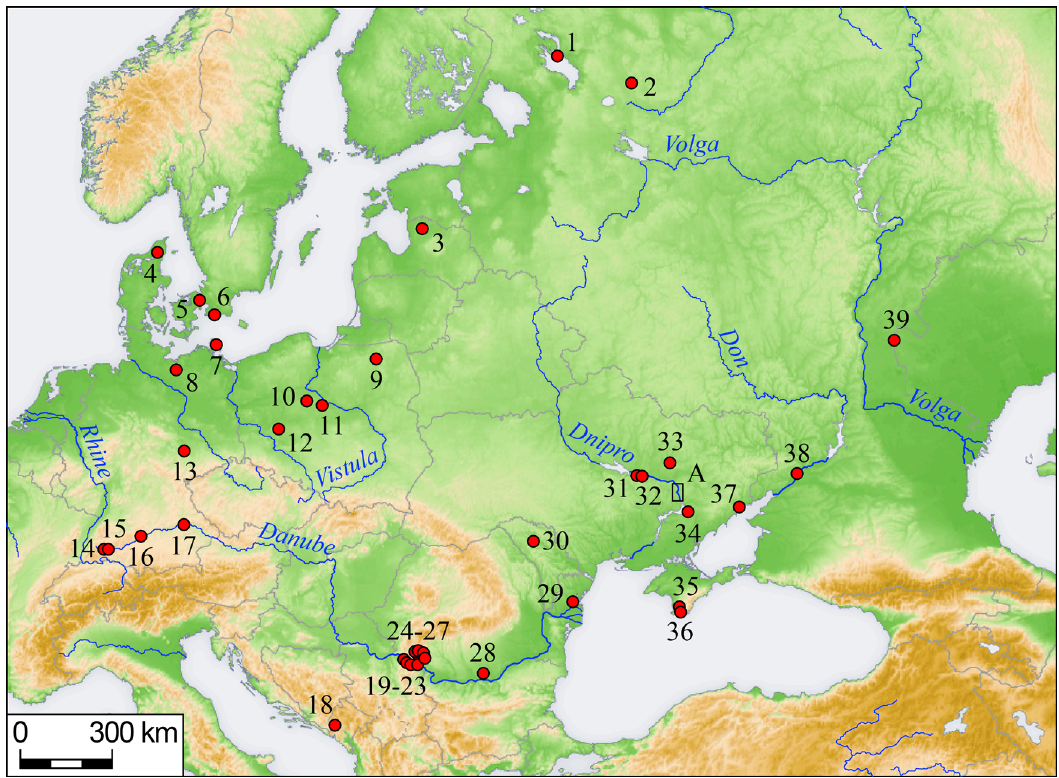
Figure 2: Distribution map of some Mesolithic and Neolithic sites out of the Dnipro Rapids region mentioned in the